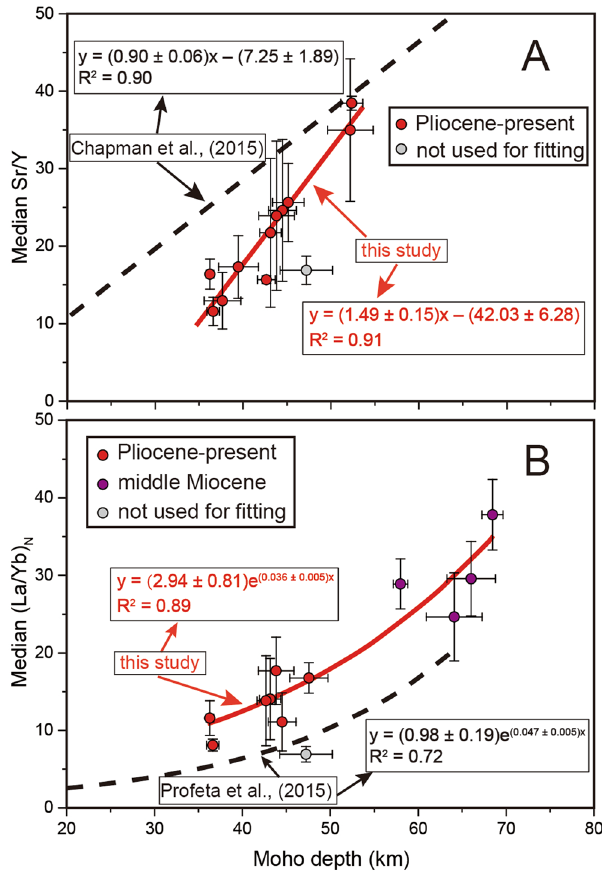
Figure 2. Global correlations between geophysically determined crustal depth (CRUST 1.0) and median Sr/Y ( A ) and median (La/Yb) N ( B ) from continental collisional belts. The red circles represent the rocks formed during Pliocene to present and purple circles represent the rocks formed at Middle Miocene. The grey circles represent data subset from continental collisional belts but not used for calculating correlation equations. Median Sr/Y and (La/Yb) N was calculated after filtration and discard of outliers; see text for detailed methods. Regression line and empirical relationship with R 2 are shown on each diagram. The red solid lines represent the results of this study and the black dash lines represent the result of study on subduction arcs by Chapman et al . (2015) 5 and Profeta et al . (2015) 7 . The plotted data are listed in Supplementary